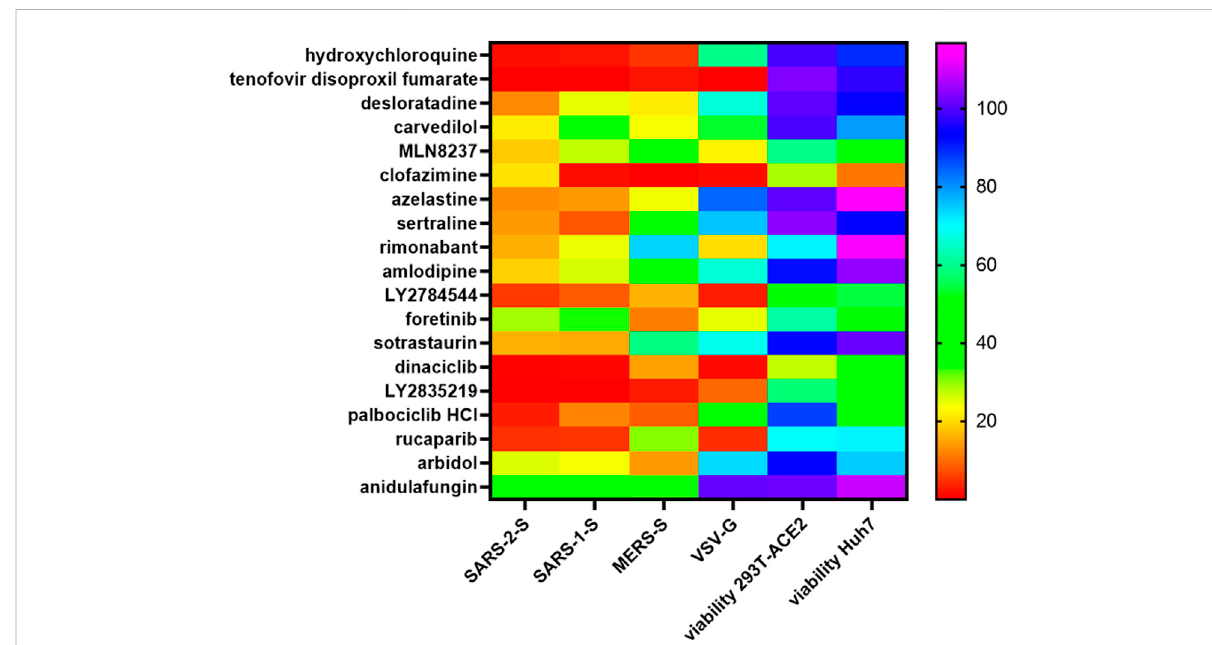
FIGURE 11 Pan-coronaviral and pan-viral fusion inhibitors. Mouse leukaemia virus pseudotyped with glycoprotein from vesicular stomatitis virus (VSV-G) andspikeprotein(S)fromsevereacuterespiratorysyndromecoronavirus(SARS-1-S),SARS-CoV-2(SARS-2-S)andMiddleEastrespiratorysyndrome coronavirus (MERS-S), was used to infect 293T-ACE2 (for SARS-1-S, SARS-2-S, VSV-G) or Huh-7 (for MERS-S) cells, in a 96-well plate for 48 h in the presence of the drug, as indicated, with 1 h pre-treatment. Infectivity was measured as luciferase activity and expressed as % infectivity versus infected, solvent control. Viability was measured by XTT assays in un-infected samples and expressed as % viability versus solvent control. Data are presented as a heat map of the mean of three